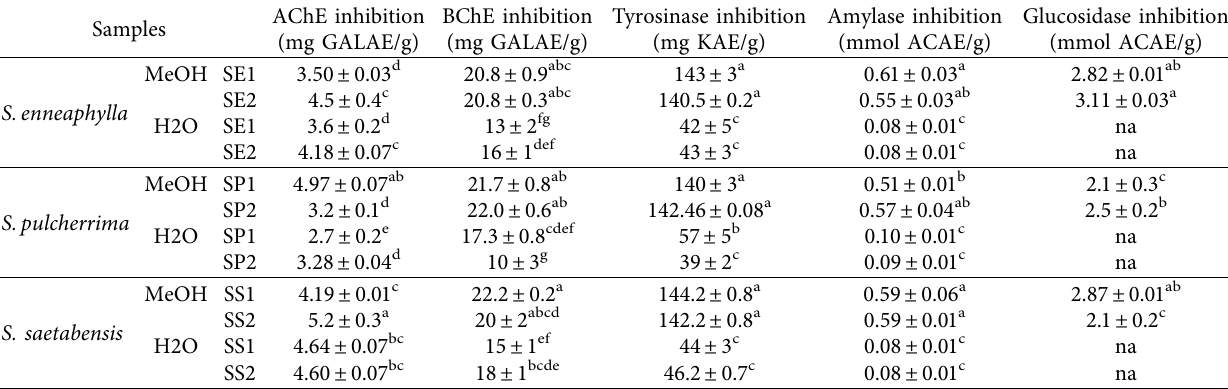
Table 7: Enzyme inhibitory properties of the extracts of S. enneaphylla (SE), S. pulcherrima (SP), and S. saetabensis (SS), each one from two different locations, extracted in methanol and water.